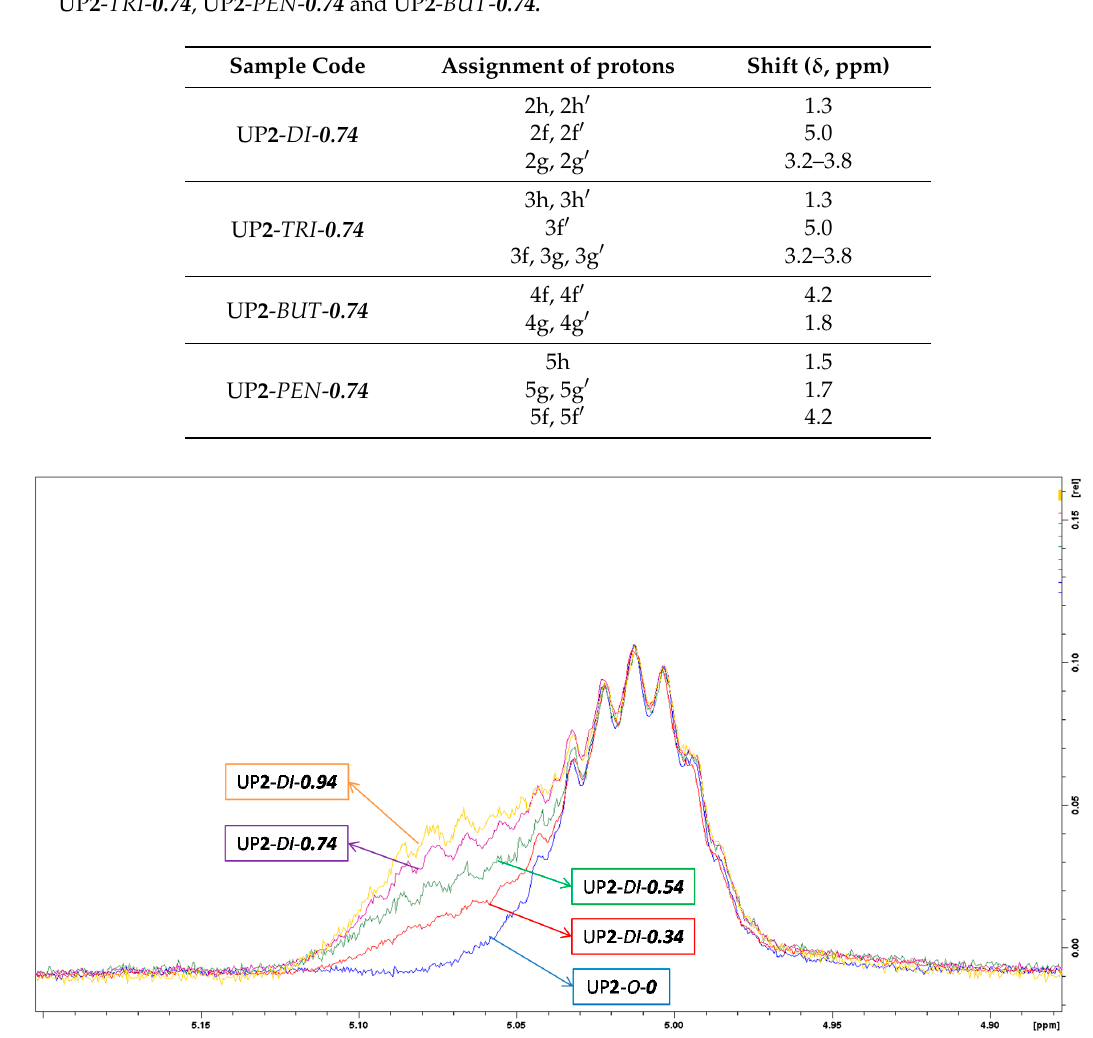
Figure 4. 1 H-NMR spectra of di-PPG chain extended samples UP 2 - DI - 0.34 , UP 2 - DI - 0.54 , UP 2 - DI - 0.74 and UP 2 - DI - 0.94 at a chemical shift range from 4.9 to 5.1 ppm.